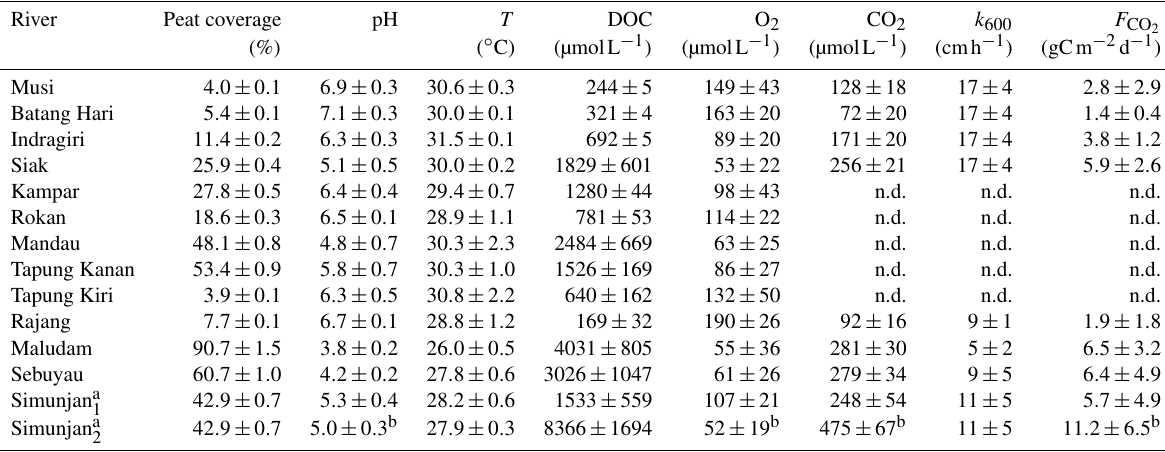
Table 3. Measured data from the investigated rivers.